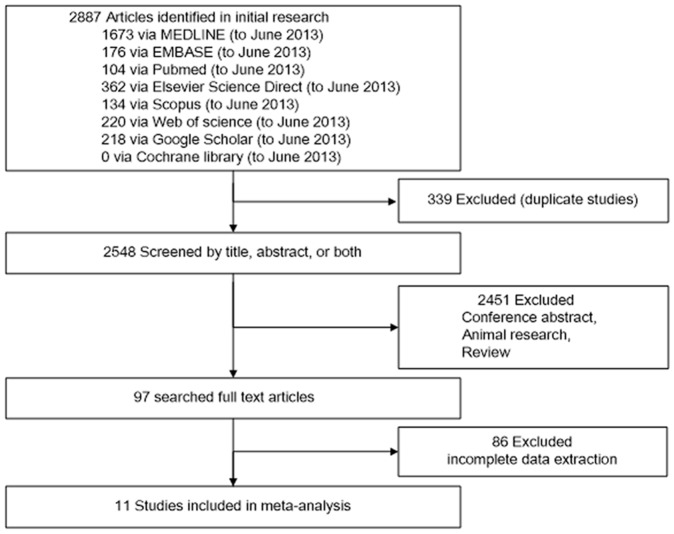
Flow diagram for the review process and outcomes of inclusion and exclusion.